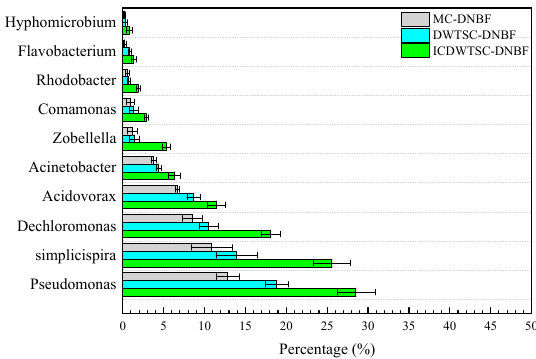
Figure 2. The relative abundance of the nutrient-related genera exhibiting significant differences (p < 0.05) in at least one of the systems.